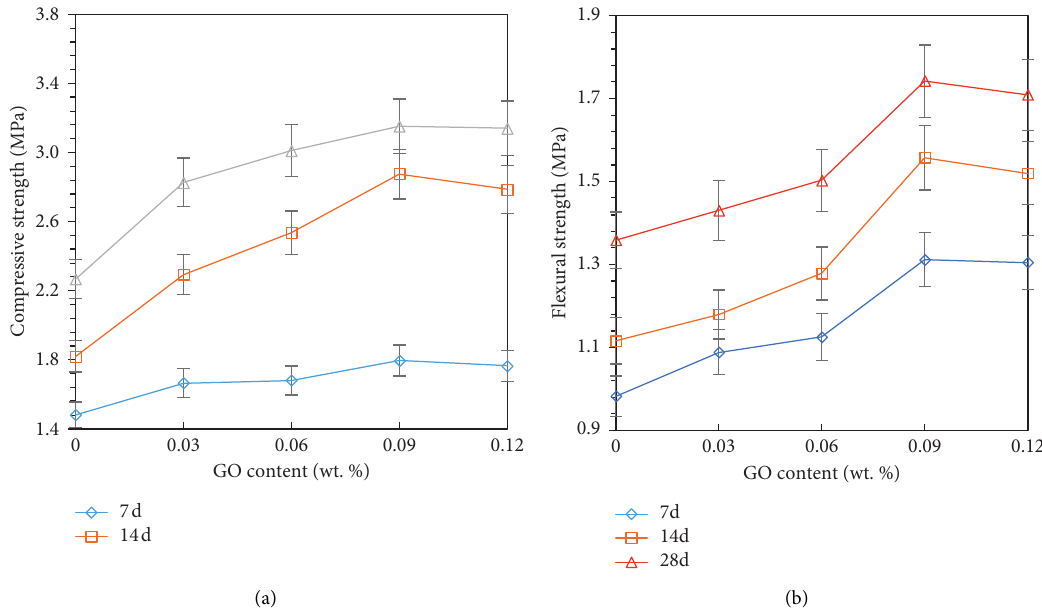
Figure 9: Curves of mechanical properties changing with GO: (a) compressive strength; (b) flexural